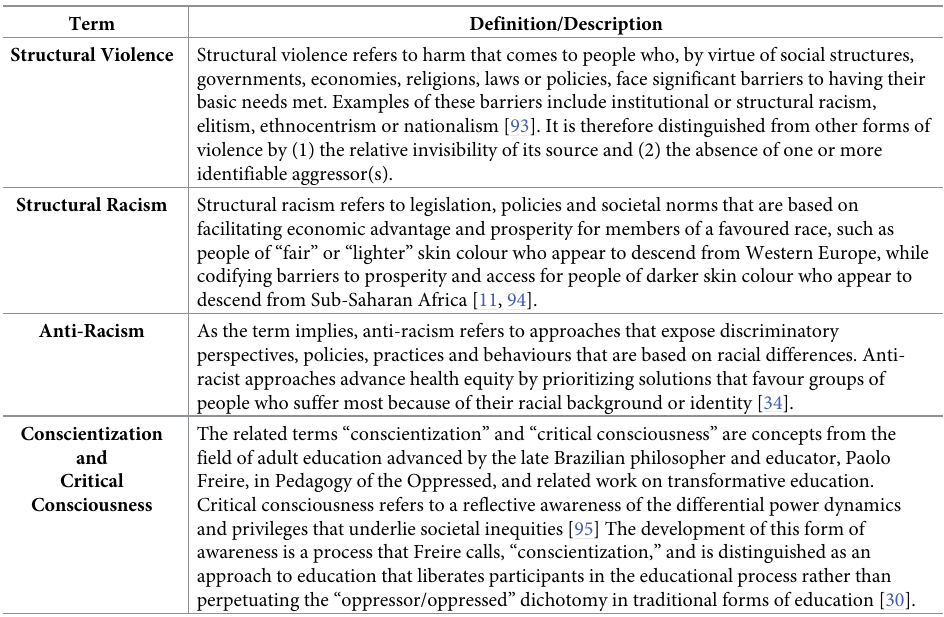
Table 3. A decolonial lexicon for global neurosurgery.